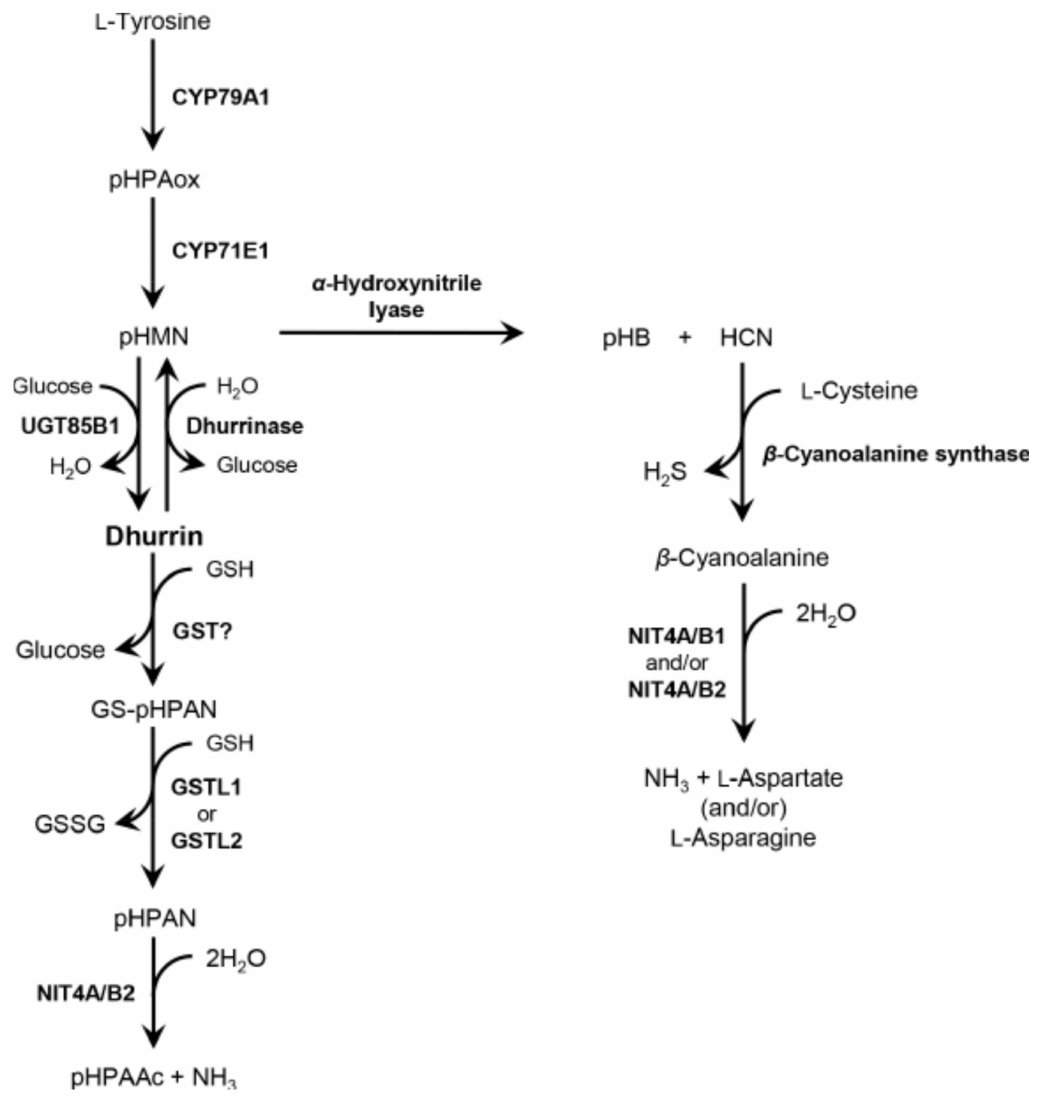
Figure 1. Dhurrin biosynthesis and degradation pathways. Dhurrin, ( S )-4-Hydroxymandelnitrile- β